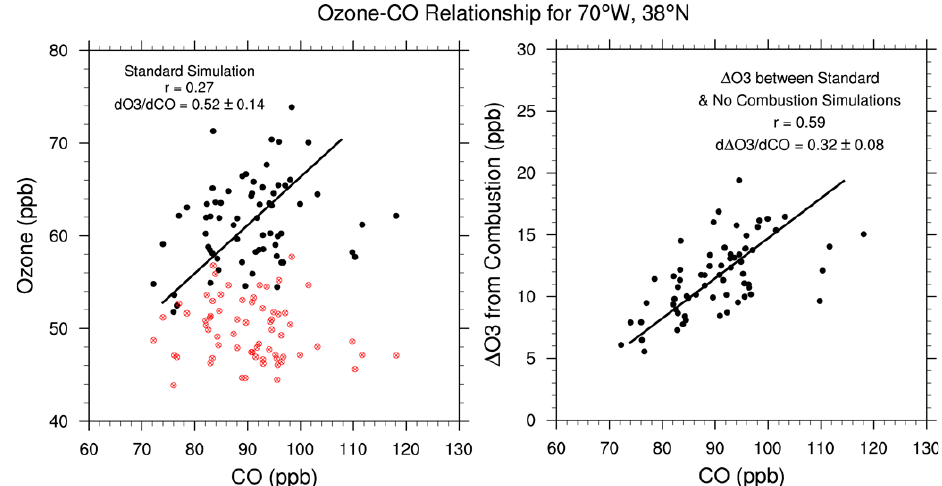
Fig. 5. Ozone–CO relationships at 700–400hPa in JJA 2008 over the western North Atlantic (2 ◦ × 2.5 ◦ grid square centered at 38 ◦ N, 70 ◦ W). Values are GEOS-Chem model results sampled daily at the local OMI and AIRS satellite overpass times and weighted by the vertical sensitivity of the instruments. In the left panel, ozone concentrations in black are from the standard simulation and in red for the sensitivity simulation including no combustion sources. CO concentrations are from the standard simulation in both cases. The right panel shows the ozone difference 1 O 3 between the standard and sensitivity simulations as a function of CO from the standard simulation, with slope d1 O 3 / d CO. All regression lines are obtained by the RMA method and the slope bound is the 95% confidence interval calculated from nonparametric